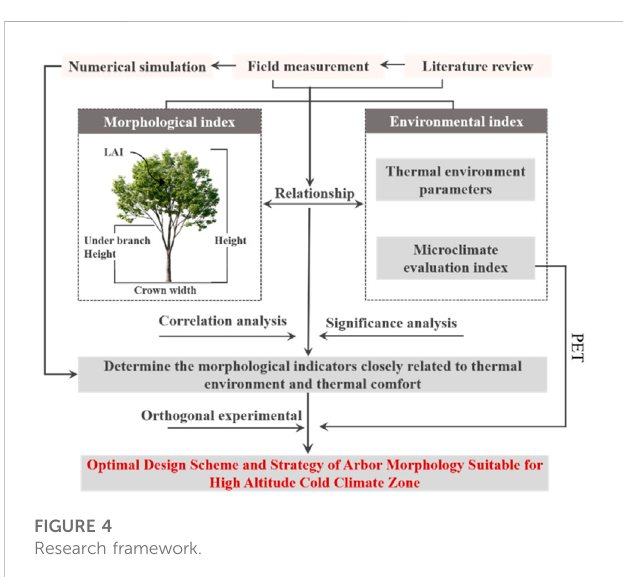
FIGURE 4 Research